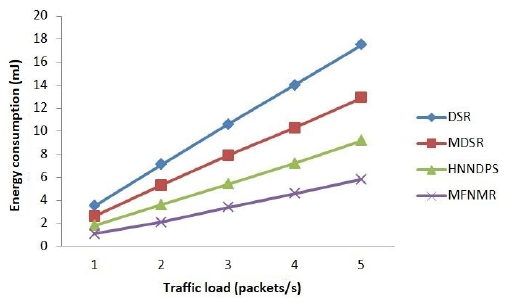
Figure 13. Energy Consumption Analysis based on Network Traffic.